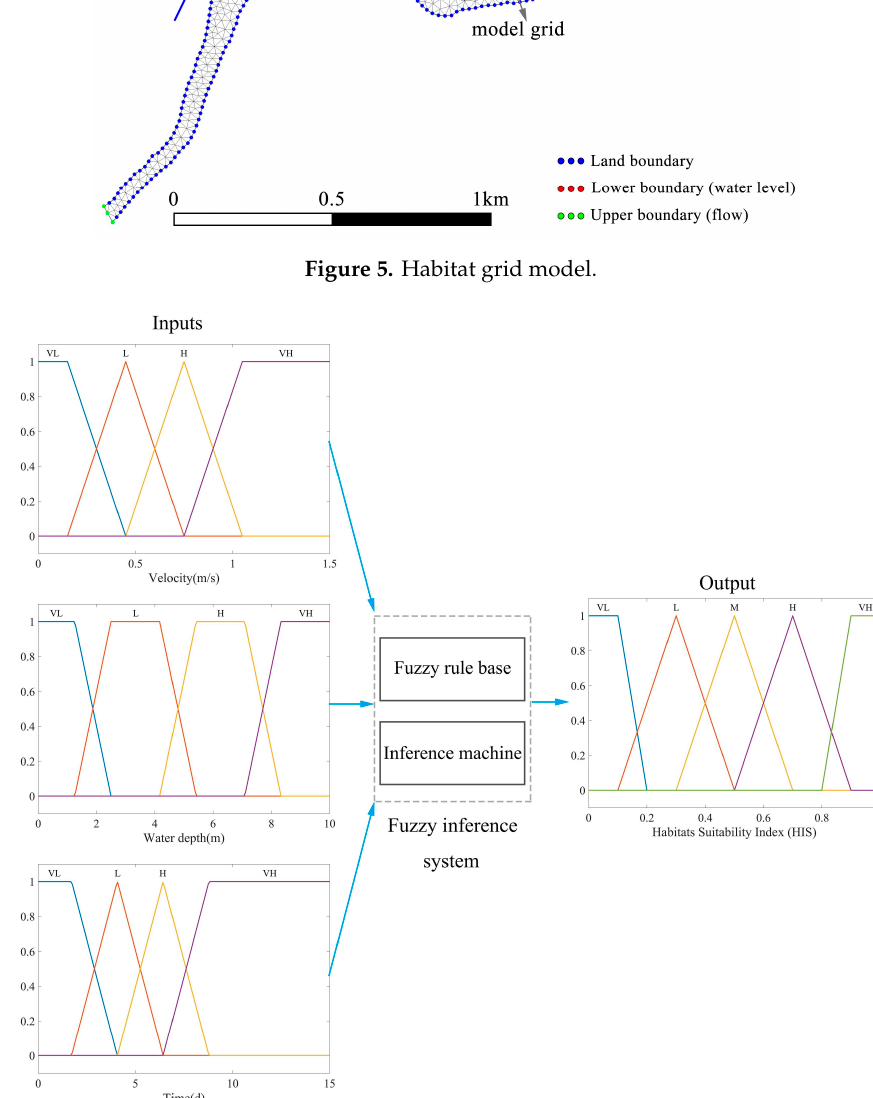
Figure 6. The modeling for the fuzzy inference process.